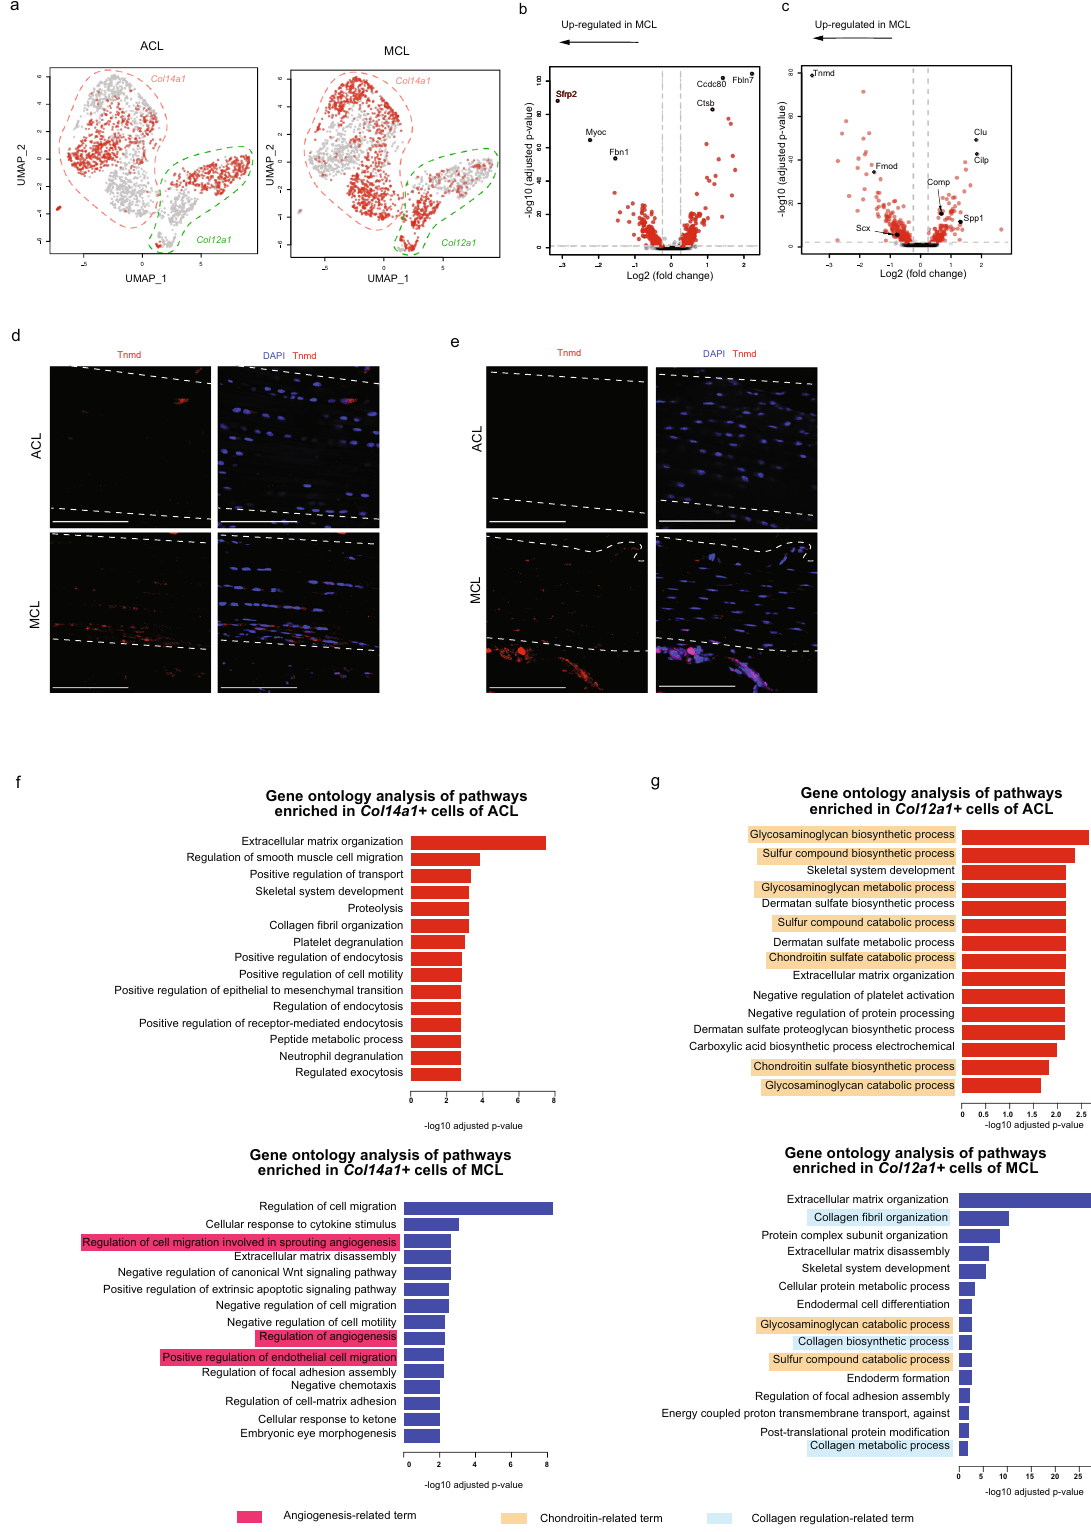
Fig. 3 Unique fi broblasts in ACL and MCL cells. a UMAP plots for Col14a1 - and Col12a1 -positive cells in the ACL and MCL. b , c Comparison of differentially expressed genes between the ACL and MCL. Volcano plots for Col14a1 - ( b ) and Col12a1 -positive cells ( c ). d , e Immunostaining ( d ) and RNA in situ hybridization ( e ) of Tnmd in mice ACL and MCL. Scale bar: 100 μ m. f , g Gene ontology analysis comparing Col14a1 - ( f ) and Col12a1 -positive cells ( g ) between the ACL and